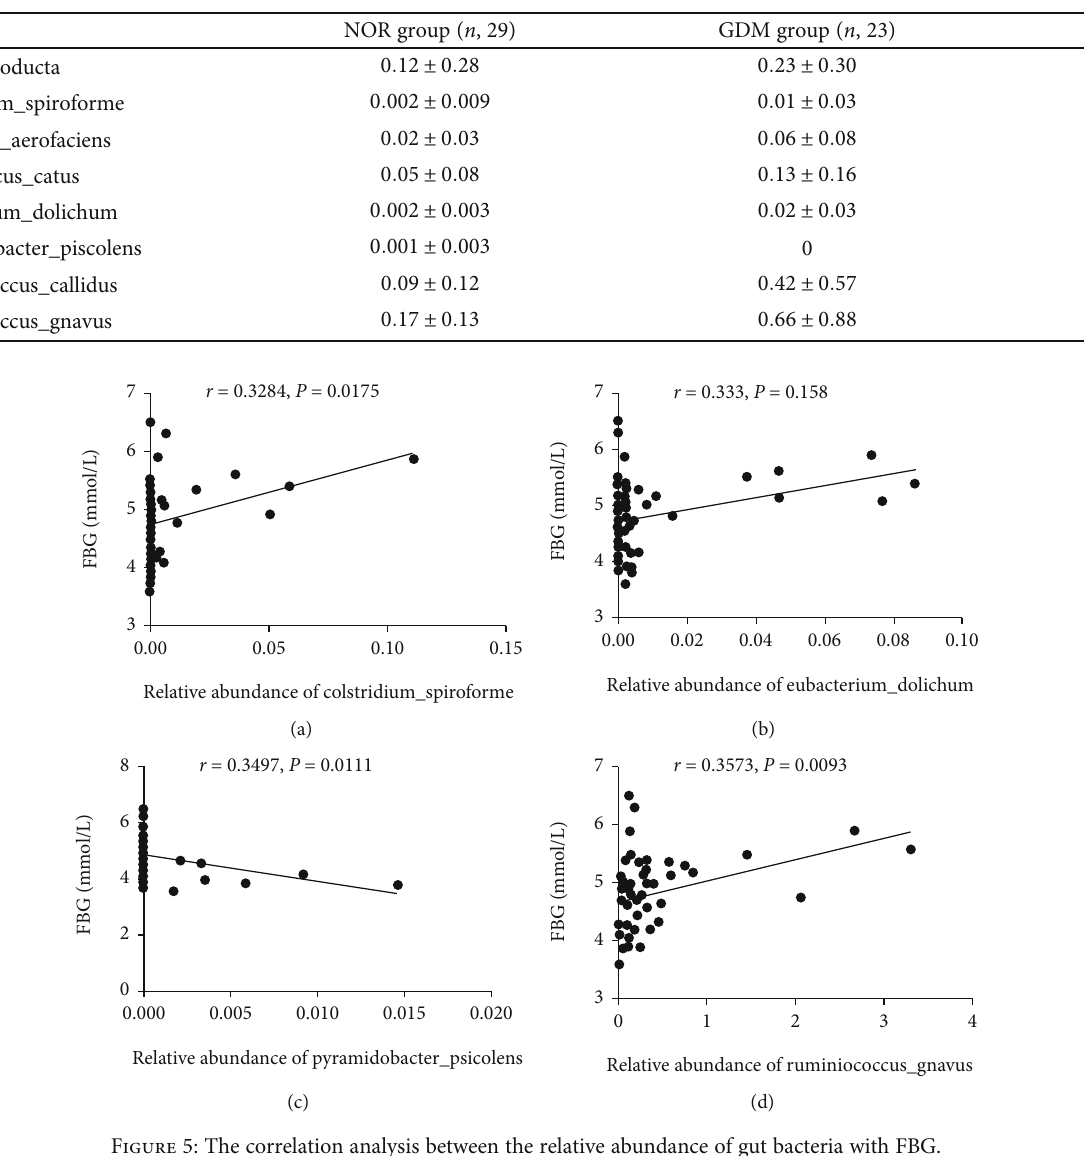
Table 2: NOR group vs. GDM group di ff erence bacteria analysis at the species level.